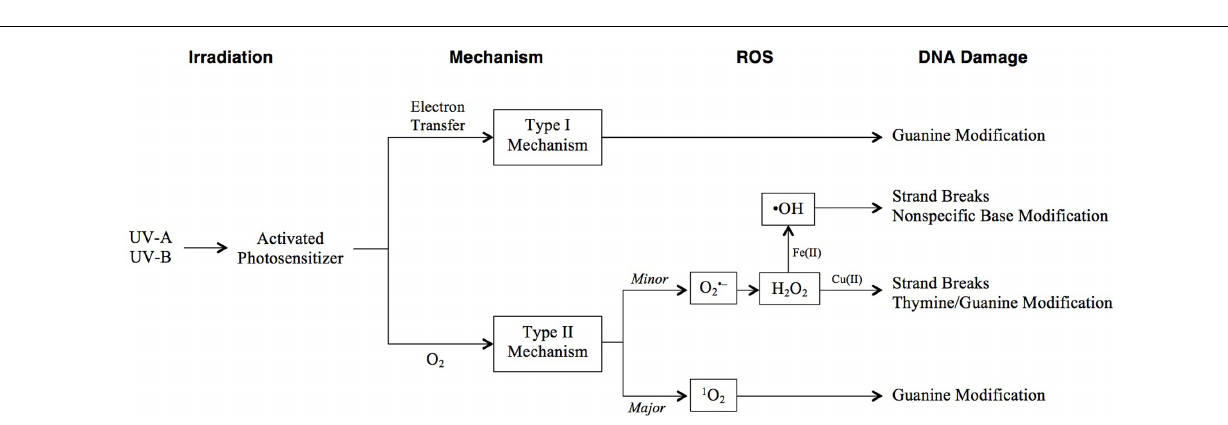
FIGURE 3 | Pathways of photooxidative DNA damage following UV irradiation. DNA damage can occur through two mechanisms: type I involves electron transfer from an excited photosensitizer to a DNA base, while type II is a direct reaction with O 2 that forms ROS. Resulting specific DNA damage is shown in the final